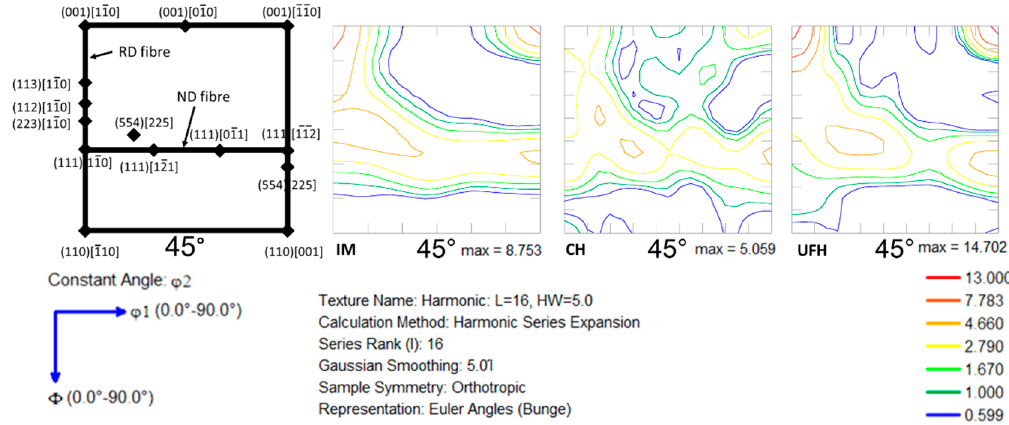
Figure 8. Positions of the most important BCC texture components in the ϕ 2 = 45 ◦ section of Euler space are shown followed by the ODF maps for the cold-rolled initial material (IM), the CH and the UFH samples. For the UFH, the cold-rolled texture of the IM is maintained due to insufficient time for recrystallization of ferrite.